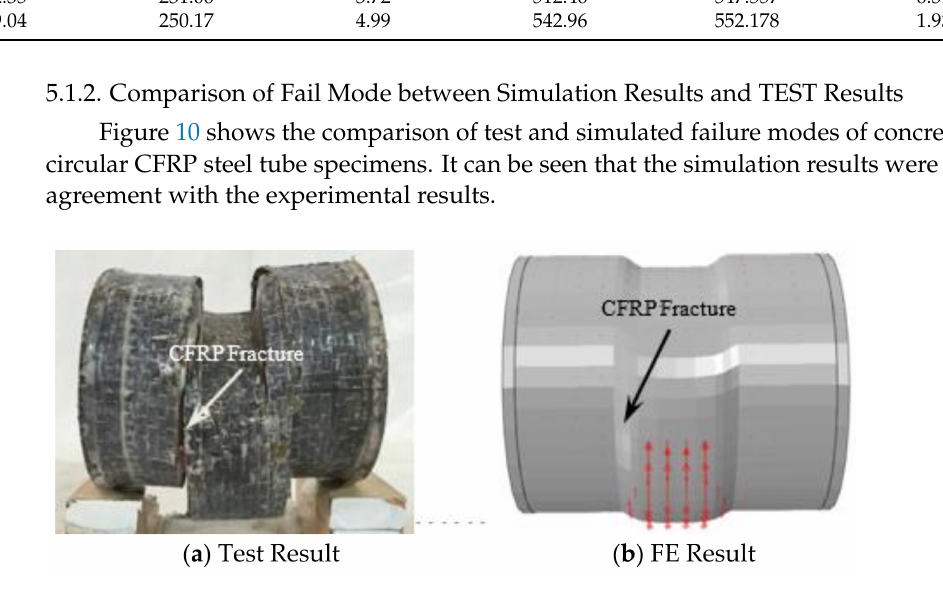
Figure 10. Comparison of test and simulated failure modes of concrete-filled circular CFRP steel